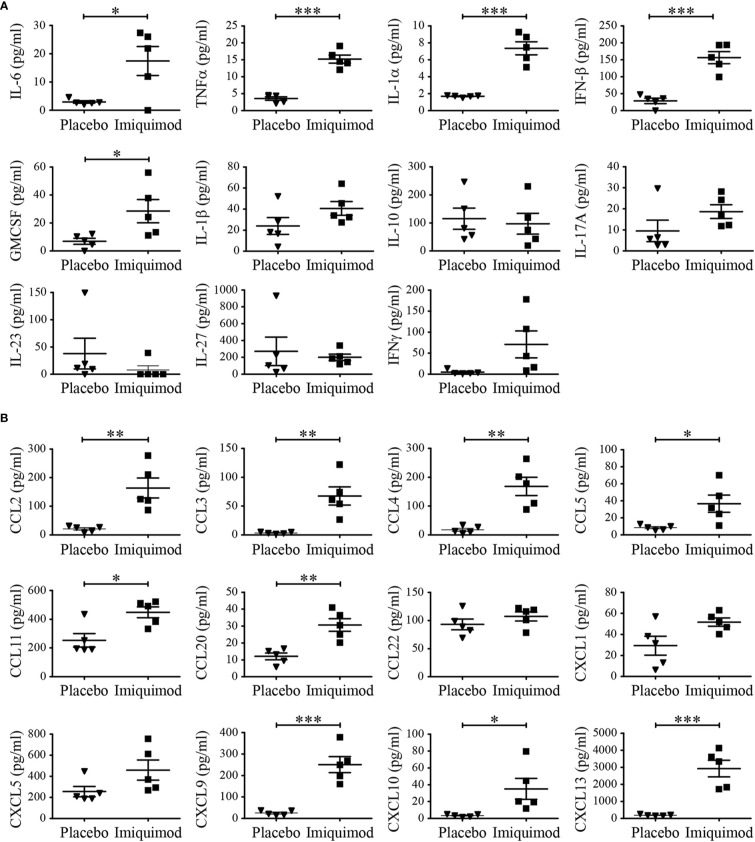
Imiquimod (IMQ) treatment induced inflammatory gene expression pattern. Naïve BALB/c mice were treated with IMQ or placebo cream for 7 consecutive days (n = 5 per group). (A, B) Cytokine/chemokines concentrations in serum of mice was analyzed at day 7 of IMQ (▪)- and placebo (▼)-treated mice with LEGENDplex multianalyte flow assay kit. In addition to individual data points, values are expressed as mean ± SEM. Student’s t-test *p < 0.05, **p < 0.01, ***p < 0.001.